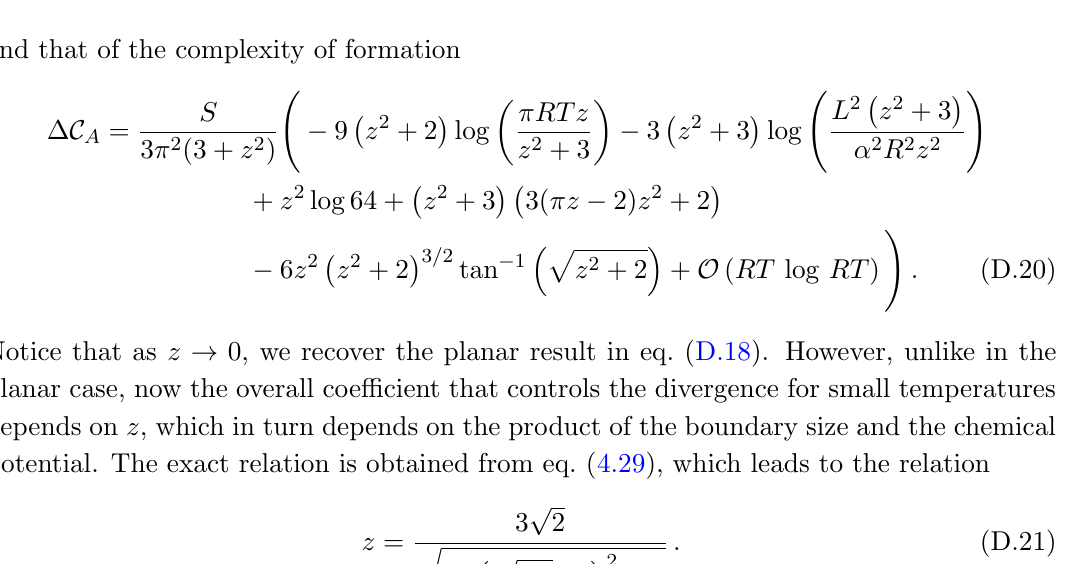
Figure 27 . Complexity of formation for spherical charged black holes in d = 4. In the left panel, we (cid:12)x RT = 1 and we show the dependence on the dimensionless boundary quantity (cid:23) . In the 2 q C J right panel, we (cid:12)x the quantity (cid:22)R = (cid:23)RT = 1 and show the dependence on RT C T